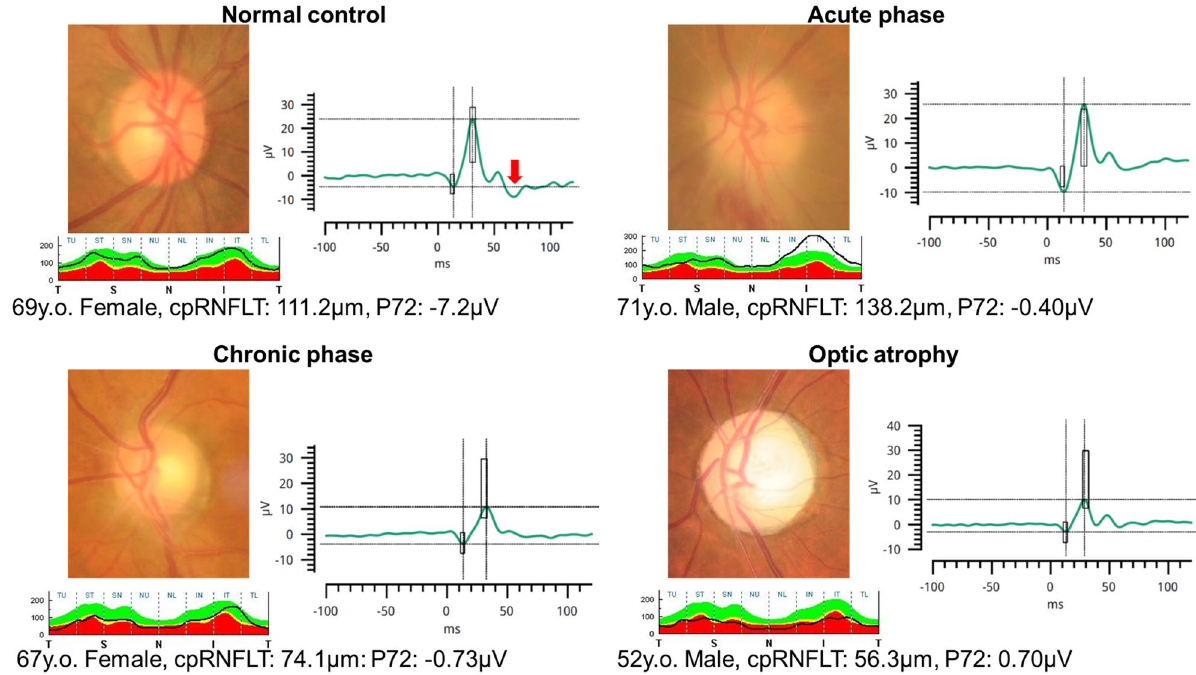
Figure 1. Representative cases of optic nerve disorders and control subjects. In each case, a photograph of the optic nerve papilla, temporal-superior-nasal-inferior-temporal (TSNIT) graph of the circumpapillary retinal nerve fiber thickness (cpRNFLT) and PhNR waveform are shown. The solid black line in the TSNIT graph represents the patient’s cpRNFLT. Top left: Normal control subjects. Full-field ERGs showing negative wave immediately after the b-wave (red arrow). Top right: Acute phase of non-arteritic ischemic optic neuropathy. Fundus photograph shows segmental optic disc swelling with flame-shaped hemorrhage. The PhNR is severely attenuated. Bottom left: Chronic phase of non-arteritic ischemic optic neuropathy. Fundus photograph shows mild atrophy of the optic disk. PhNR is severely attenuated. Bottom right: Traumatic optic neuropathy. Fundus photograph shows pallor of the optic disk. The PhNR is severely There was no significant difference in the amplitudes of the b-wave between the normal control group and optic nerve disorders group. The averaged pupil diameter during the PhNR recording was significantly larger in the chronic ON and ION groups and TON/DOA groups. The cpRNFLT was reduced significantly in the patients with overall optic nerve disorders compared to that of the normal control group ( P = 0.001), and the cpRNFLT was significantly thicker in the acute ON/ION group ( P = 0.009). The GCCT was reduced significantly in the chronic ON and ION groups and in the TON and DOA groups ( P = 0.001), but there was no significant difference in patients with acute ON and ION ( P = 0.905). Fundus photographs and PhNRs of representative cases of optic nerve disorders and control group are shown in Fig. 1. In the control group, full-field ERGs showed a negative wave at 72 ms (red arrow), but in the optic nerve disorders groups, the negative wave after the b-wave was considerably smaller. Correlation between PhNRs and cpRNFLT and ganglion cell complex thickness in eyes with optic nerve disorders. The correlations between the different components of the PhNRs and the cpRN- FLT and the ganglion cell complex thickness (GCCT) are shown in Table 3. The cpRNFLT was weakly but significantly correlated with the P 72 , P min , and P ratio amplitudes in all cases of optic nerve disorders ( r = − 0.356, P = 0.013; r = − 0.334, P = 0.020; and r = 0.299, P = 0.039, respectively). In the acute ON/ION eyes, the cpRNFLT was weakly but significantly correlated with the W ratio ( r = − 0.553, P = 0.049), but the cpRNFLT was not sig- nificantly correlated with the PhNR components in the chronic ON/ION eyes. In the TON/DOA group, the cpRNFLT was significantly correlated with the P min and the W ratio ( r = − 0.720, P = 0.008; r = 0.650, P = 0.022; respectively). The correlation between the PhNRs and the GCCT was not significant. A scatter plot of the W ratio and the cpRNFLT is shown in Fig. 2. There was no significant correlation between the W ratio and cpRNFLT for the optic nerve disorders grouped together ( r = 0.170, P = 0.247). However, there was a significant negative correlation between the W ratio and cpRNFLT in eyes at the acute ON and ION phase ( r = − 0.553, P = 0.049) but there was no significant correlation in the chronic ON and ION phase ( r = 0.168; P = 0.443). There was a significant positive correlation between the W ratio and cpRNFLT in the TON/DOA group ( r = 0.650; P = 0.022). Scatter plots of all PhNRs and cpRNFLTs were constructed (Supplementary Fig. 1), and we found that the analyses performed using P 72 , P min , and P ratio showed the same trend as the analyses performed using W ratio .